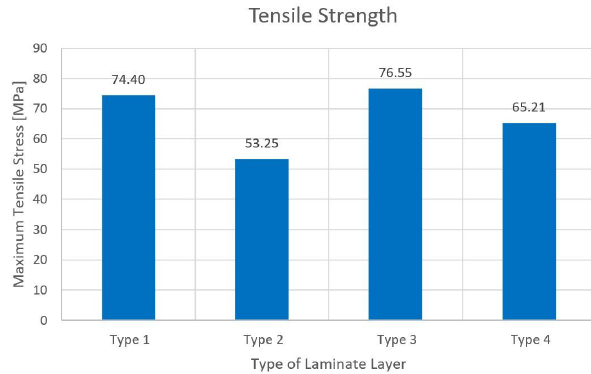
Figure 4: Characteristics of the tensile strength of HCGFRP in each configuration of the